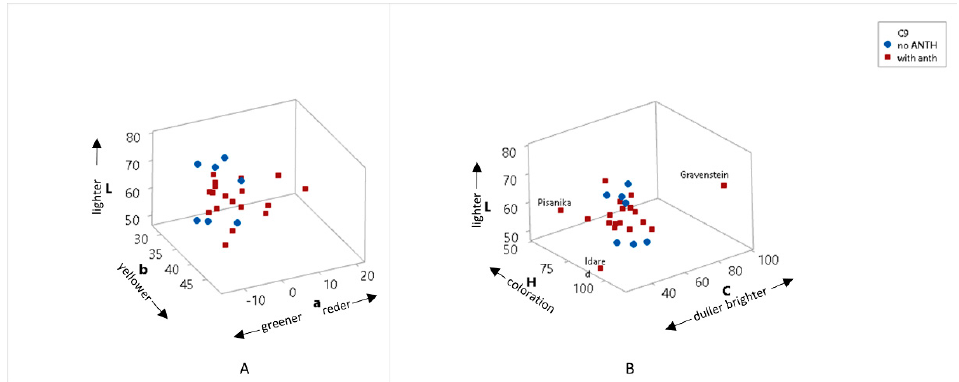
Figure 1. The color of apples ( A ) in CIE L*a*b* coordinates (where L* represents lightness, a* refers to red/green coordinate, b* is yellow/green coordinate), ( B ) in CIE L*C*H* coordinates (where L* represents lightness, C* refers to chroma, H* is the hue angle).